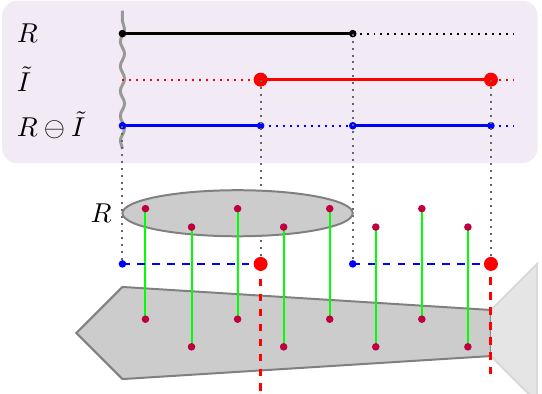
Figure 2 . The relation between the ‘islands in the stream’ and the ‘bridge to nowhere’ [57, 58]. As the black hole evaporates, the bridge grows to the right and modes along the bridge are entangled with modes in the radiation as shown by the green lines. The island in the stream ˜ I cancels out part of the entanglement of R with the bridge but adds in additional entanglement shown as the blue cut on the right. The contributions from the QES correspond to cutting across the ‘bridge to nowhere’ along the red cuts. The configuration shown here will not be an extremum of the generalized